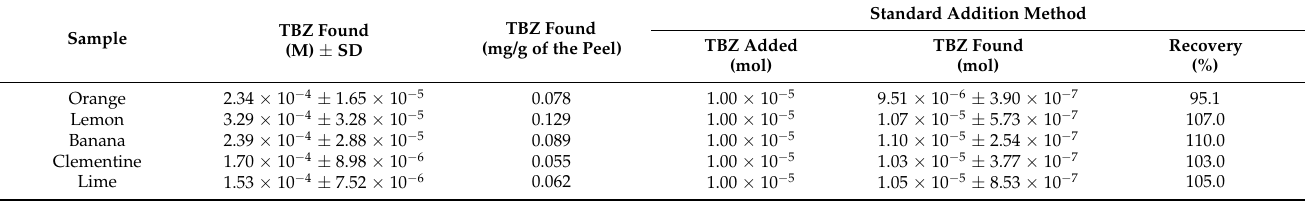
Table 5. Results of the TBZ determination in real samples obtained using Gran method 1 .